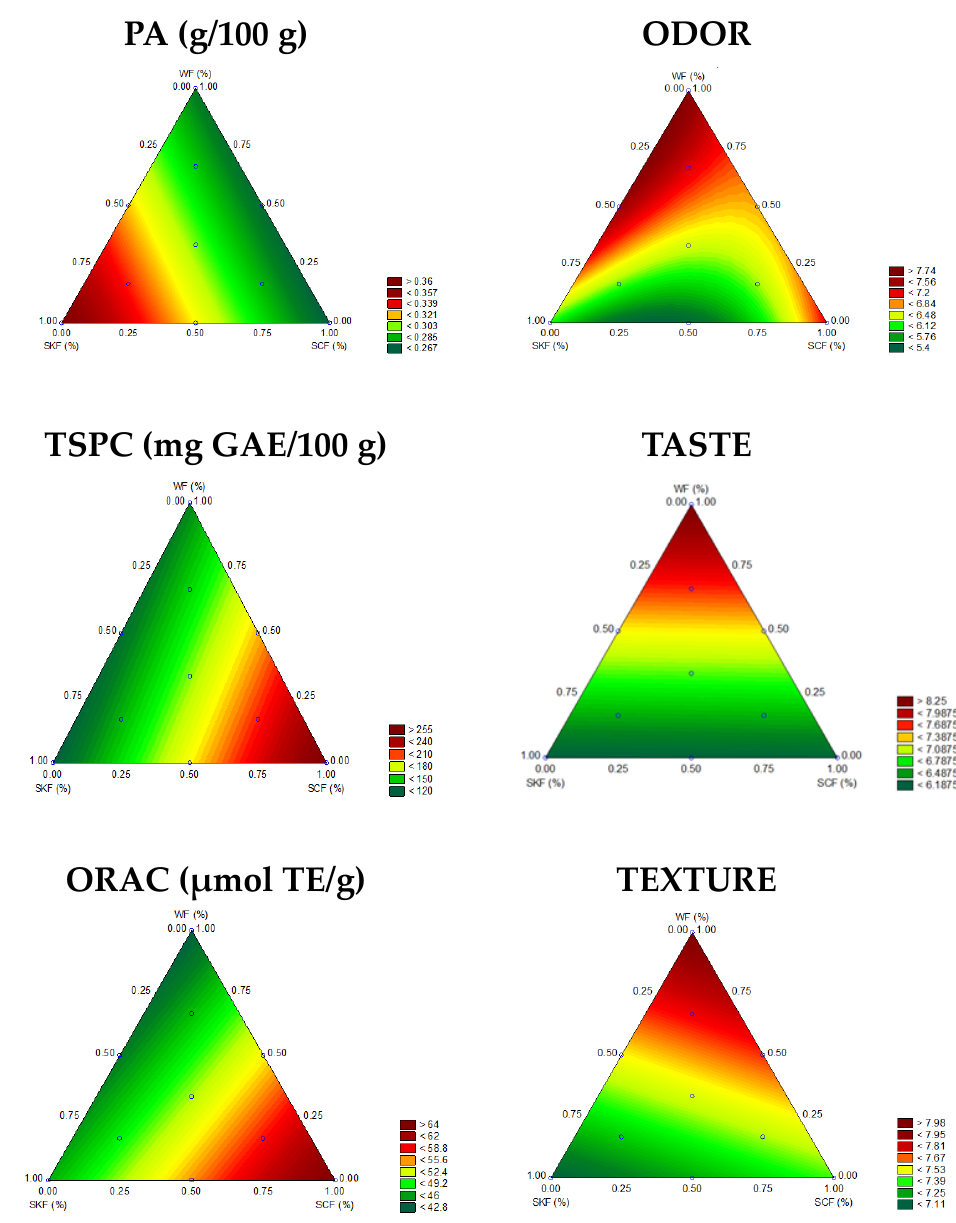
Figure 1. Contour plots of predicted PA, TSPC, ORAC and sensory acceptability scores (10-cm hedonic scale for odor, taste and texture) of breads. Abbreviations: GAE, gallic acid equivalents; ORAC, oxygen radical absorbance capacity; PA, phytic acid; SCF, sprouted cañihua flour; SKF, sprouted kiwicha flour; WF, refined wheat flour; TSPC, total soluble phenolic compounds; TE, Trolox